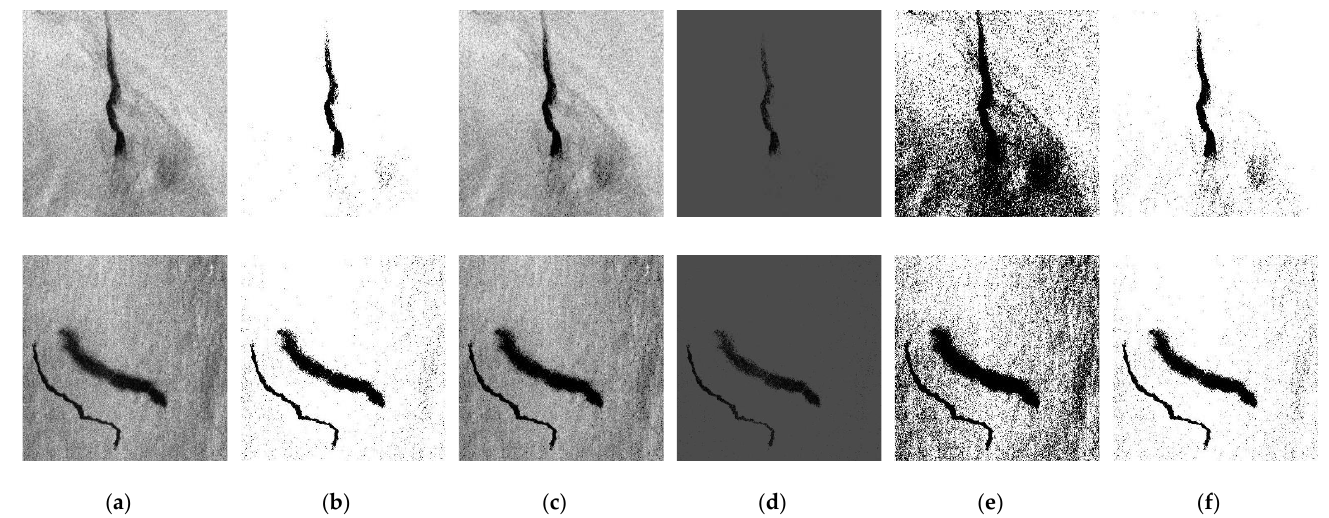
Figure 8. ( a ) Original image, ( b ) Binary segmentation, ( c ) ToZero segmentation, ( d ) Truncate segmentation, ( e ) OSTU segmentation, and ( f ) Triangle segmentation. The four processing methods of ( b , d – f ) are mainly for bright areas. ( c ) is mainly to strengthen the characteristics of dark areas.